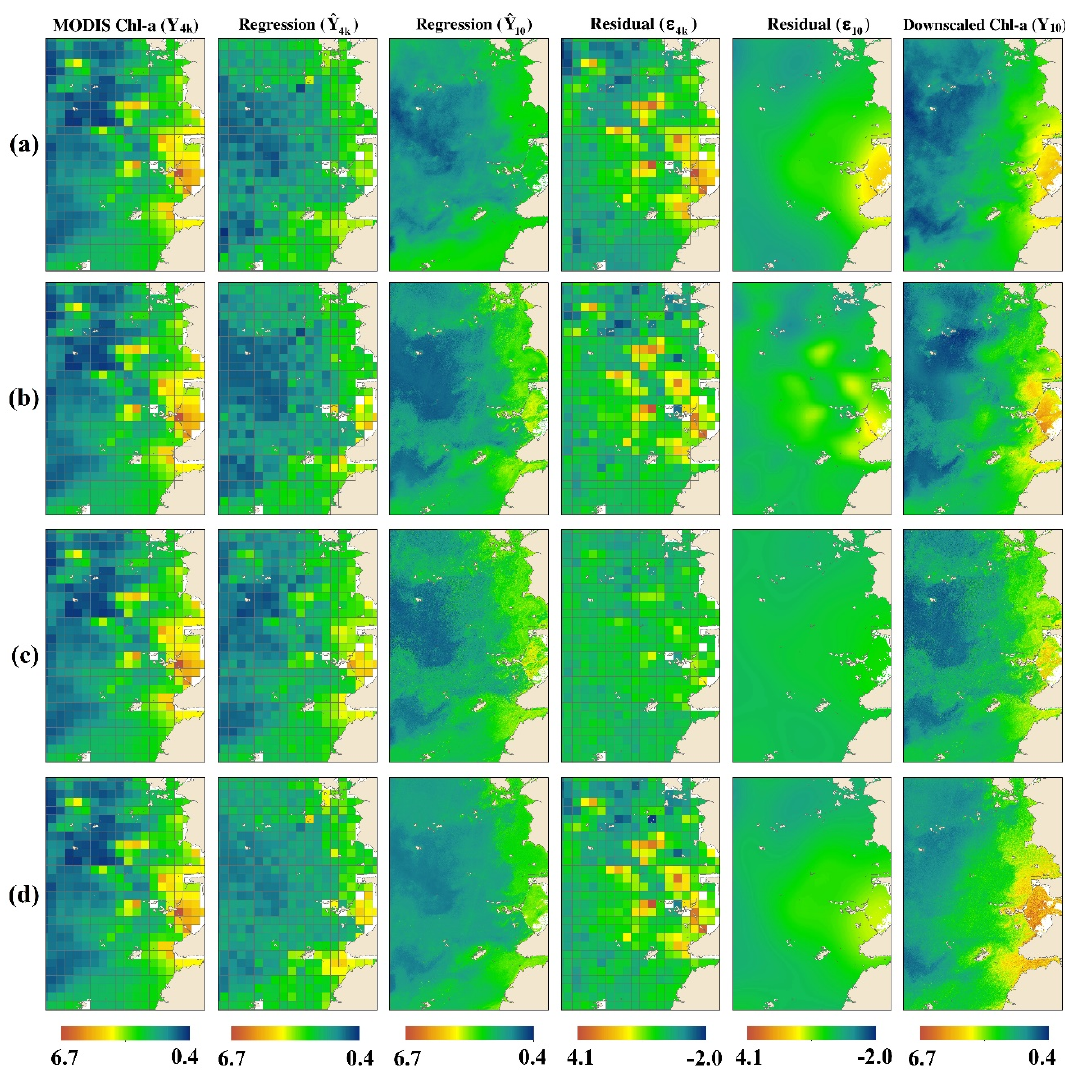
Figure 7. Detailed maps showing the downscaling steps for all models on the summer day (2016.8.4);